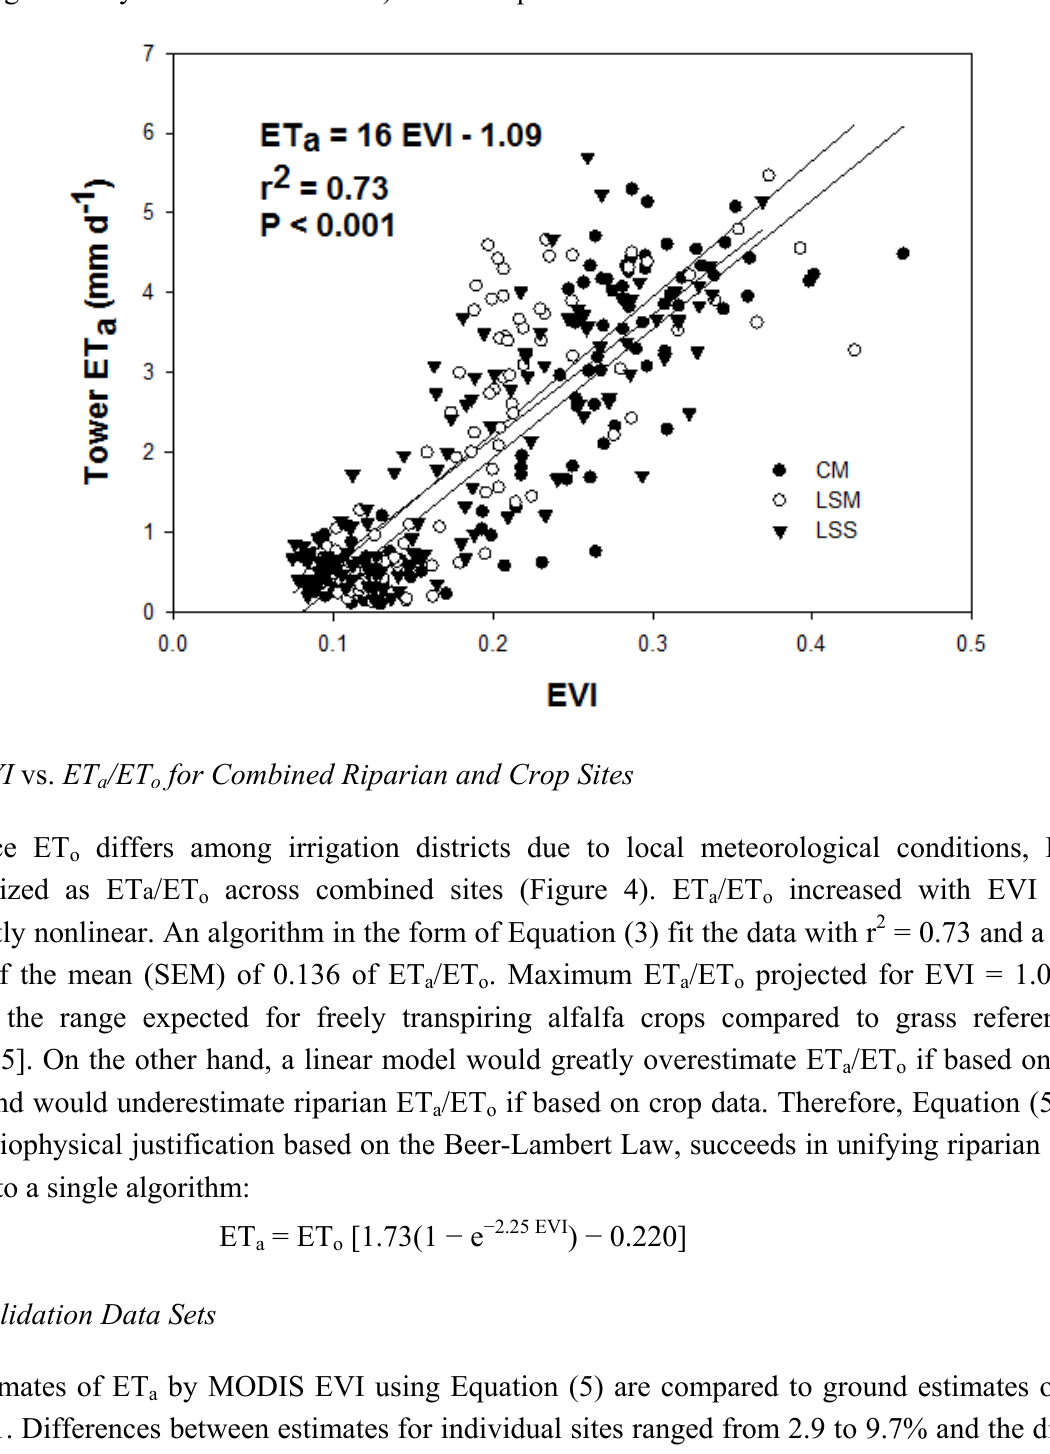
Figure 3. Scatter plot of ET measured at flux towers on the San Pedro River used for a model calibration and EVI; CM = Charleston mesquite site; LSM = Lewis Spring mesquite site; LSS = Lewis Spring sacaton grass site. Black lines are best fit for individual sites (not significantly different at P = 0.05) and the equation is for all sites